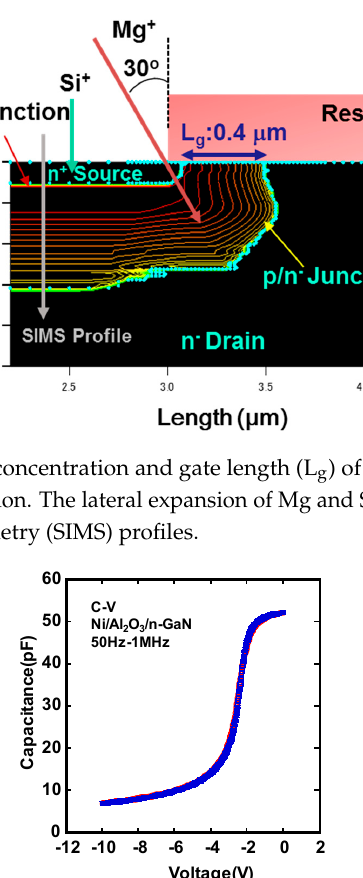
Figure 8. The C-V characteristics of Ni/Al 2 O 3 /n-GaN MOS capacitors measured from 50 Hz to 1 MHz.